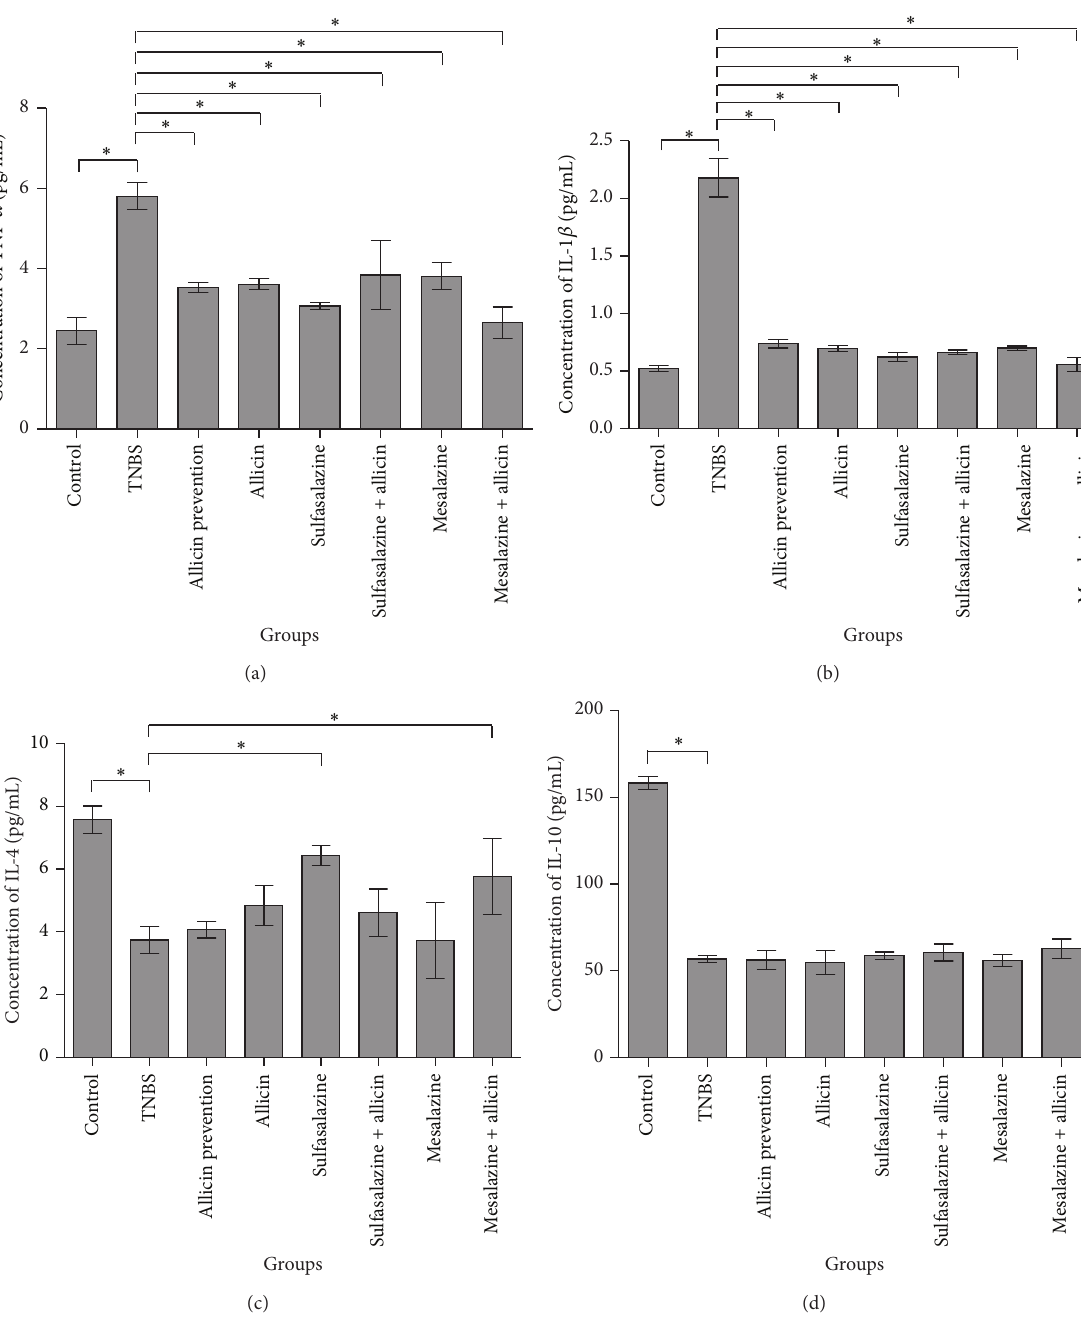
Figure 3: Levels of cytokines in the serum. Serum TNF- 𝛼 and IL-1 𝛽 levels of TNBS-induced rats were dramatically decreased by drug treatment, and mesalazine + allicin group was the lowest (a and b); sulfasalazine and mesalazine + allicin rose serum IL-4 level; however, these drugs did not alter serum IL-10 level (c and d). Data were presented as mean ± SD. ∗ 𝑃 < 0.05 versus TNBS